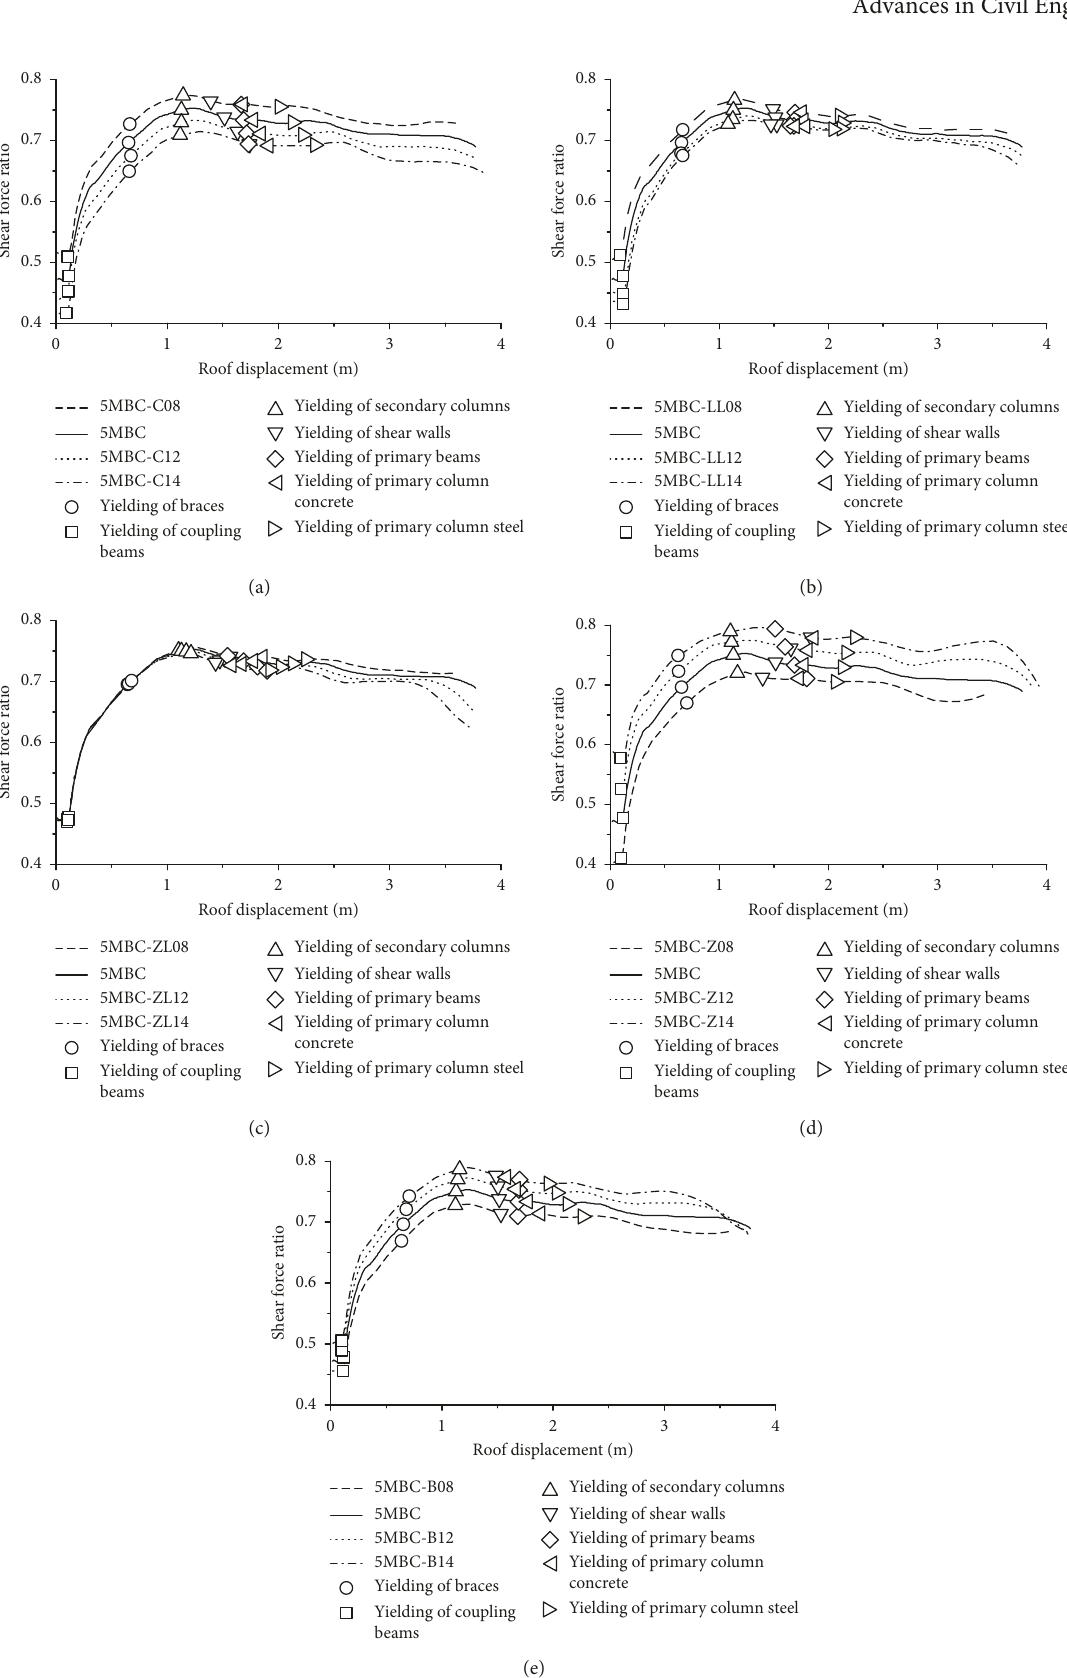
Figure 16: Influence of key parameters on shear force ratio of primary frame in model 5MBC: (a) thickness of shear walls, (b) height of coupling beams, (c) height of primary beams, (d) sectional area of primary columns, (e) sectional area of